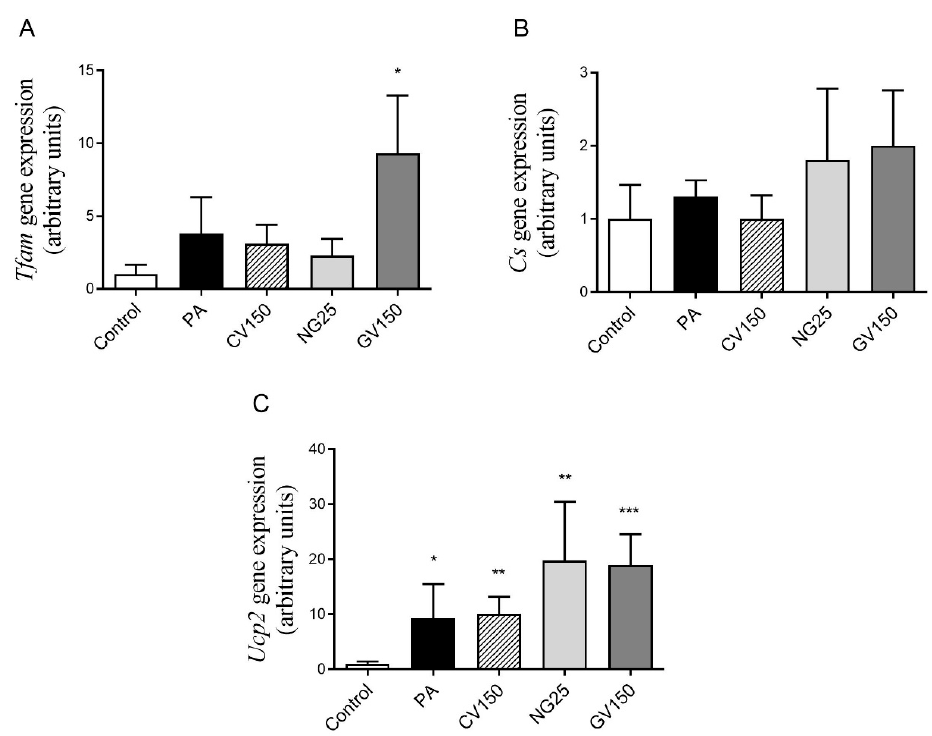
Figure 7. Gene expression of Tfam ( A ) and Cs ( B ) and Ucp2 ( C ) in AML12 hepatocytes exposed or not to 0.3 mM of palmitic acid (PA) with or without Chlorella vulgaris (CV) at 150 µ g/mL, Nannochloropsis gaditana (NG) at 25 µ g/mL and Gracilaria vermiculophylla (GV) at 150 µ g/mL for 18 h. Data are means ± SEM (standard error of the mean).* p < 0.05, ** p < 0.01 and *** p < 0.001 vs. control group. Cs : citrate synthase; Tfam : mitochondrial transcription factor A, Ucp2 : uncoupling protein 2.